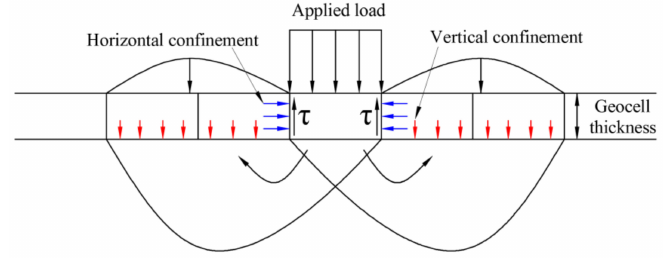
Figure 1. Soil enclosure characteristic by